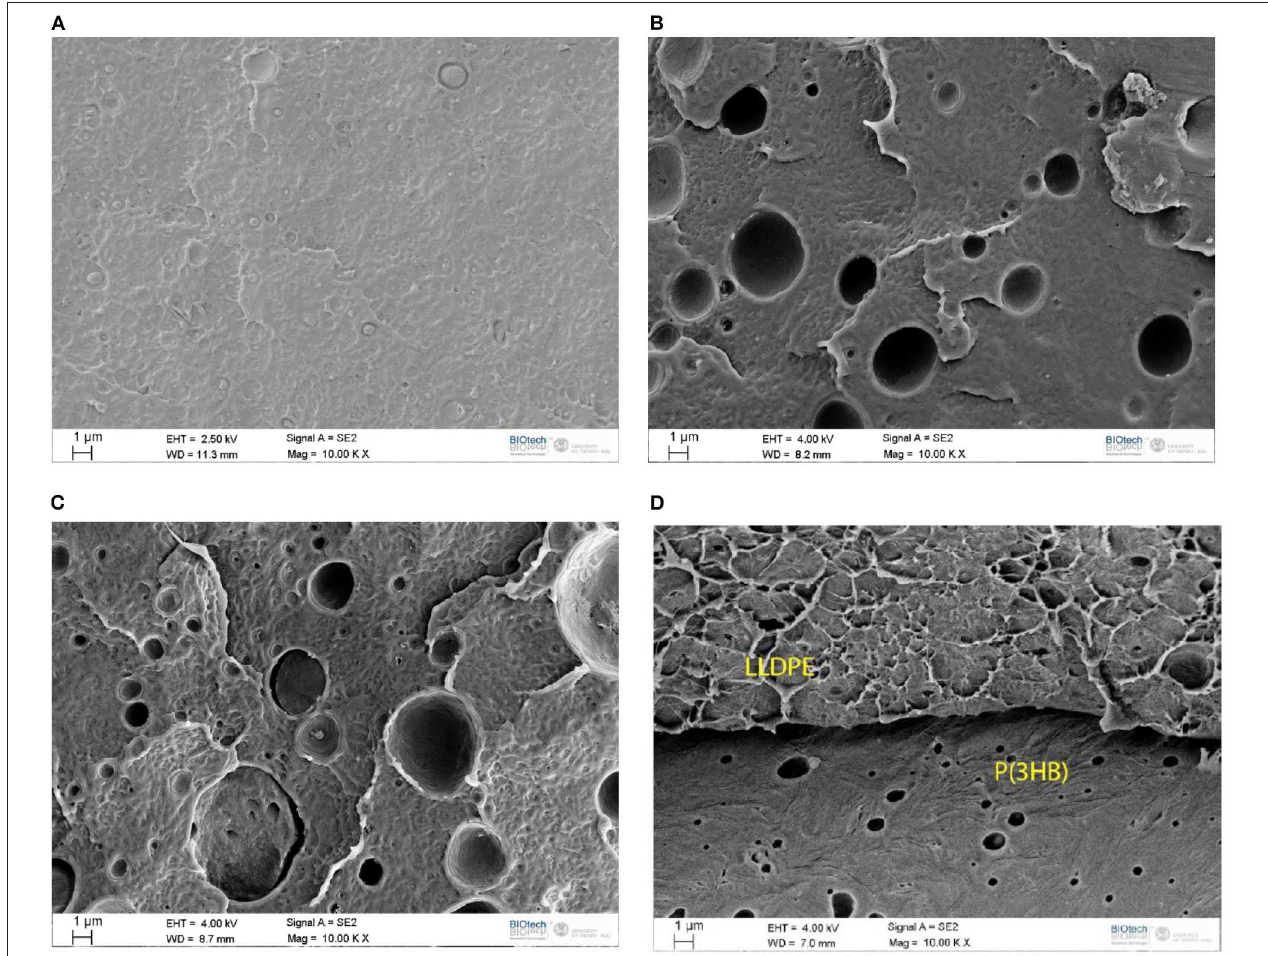
FIGURE 2 | SEM micrographs of the cryofractured surface of (A) neat LLDPE, (B) LLDPE _90_PHB_10, (C) LLDPE _80_PHB_20, (D) LLDPE